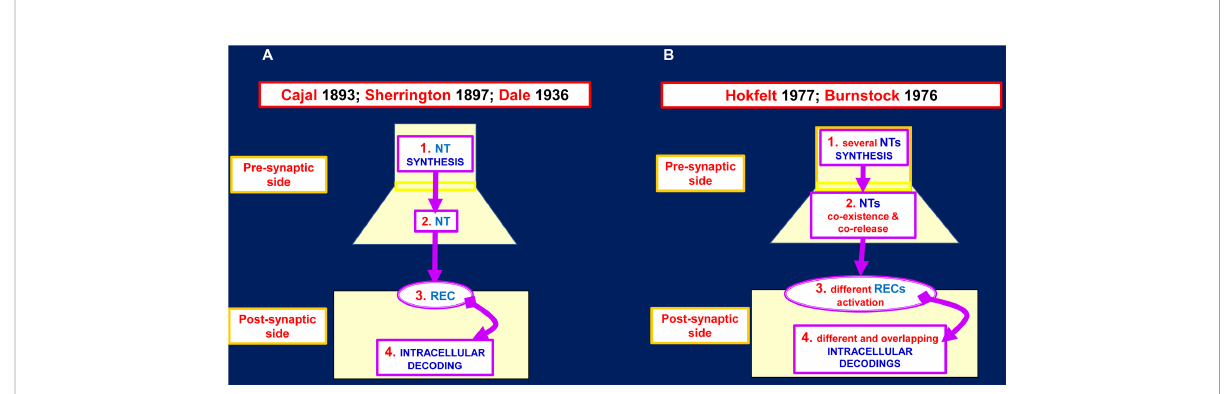
FIGURE 2 Proposed models for the chemical synapse. (A) Several neurotransmitter (NT) inputs like the one indicated in the scheme could impinge on the postsynaptic side. The integrated inputs result in the postsynaptic output: FIRE/NOT FIRE. In principle the pharmacological interventions could be devised on any of these four steps of the chemical synapse. (B) Several NT inputs like the one indicated in the scheme could impinge on the postsynaptic side. The integrated inputs result not only in the postsynaptic output: FIRE/NOT FIRE but also in complex biochemical adjustments. In principle the pharmacological interventions should be devised in a much more complex context. For further details see (8) and the herewith cited bibliography. See also (9 – 14). NT, neurotransmitter; REC,